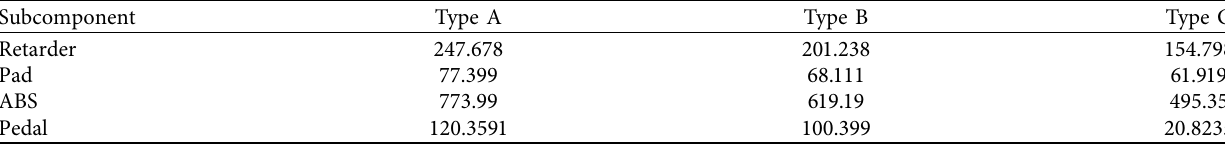
Table 2: Price of subcomponents (USD).